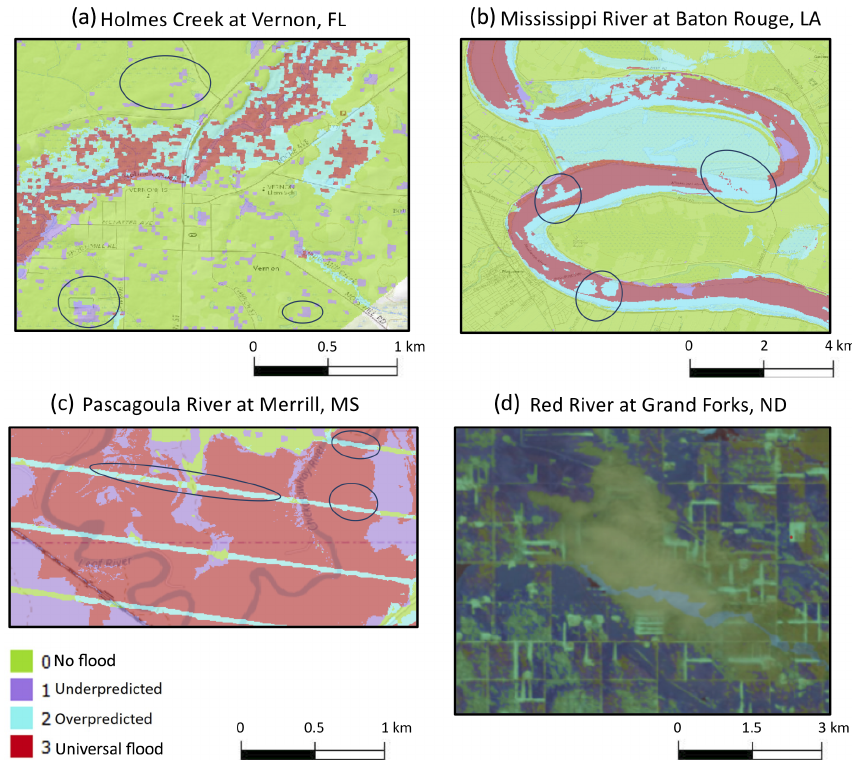
Figure 9. Errors due to classification and image artifacts: (a) dark vegetation misclassified as water due to spectral similarity. (b) Misclassified channel segments due to spectral similarity. (c) Scan line errors in input RS image create gaps in flooded extent. (d) Clouds and melted snow create ambiguities in flooded extent